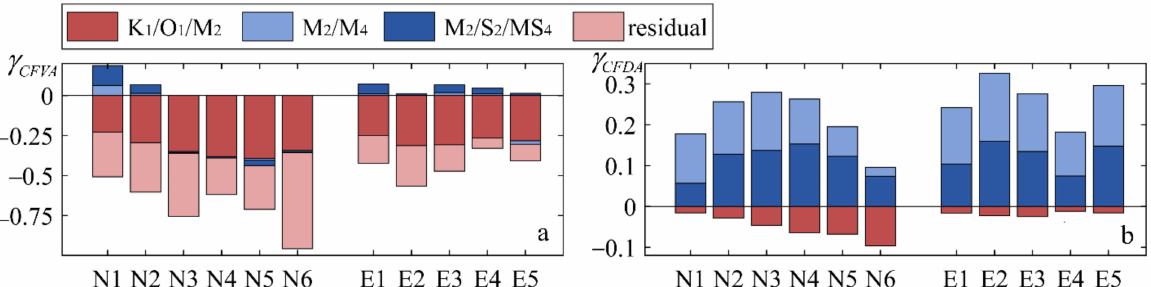
Figure 8. Skewness of the main tidal components, K 1 /O 1 /M 2 (deep red column), M 2 /M 4 (light blue column), M 2 /S 2 /MS 4 (deep blue column), and residual current (light red column) of the